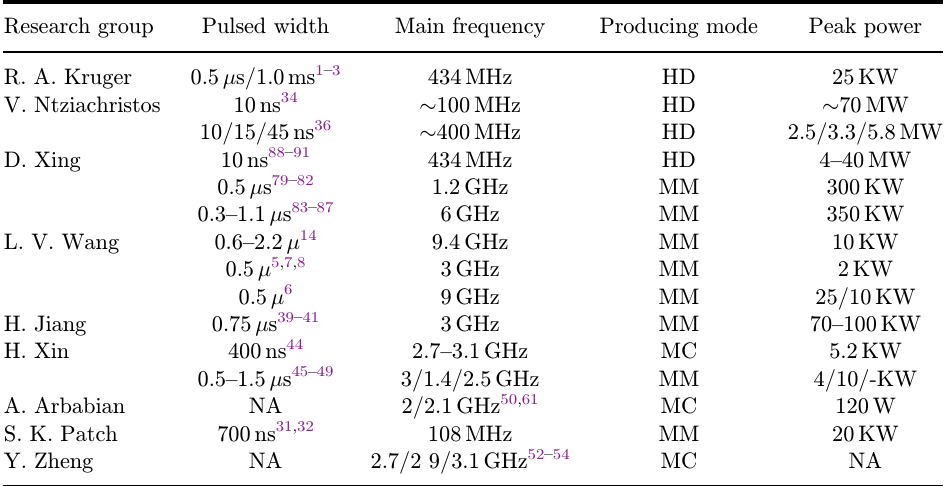
Table 1. Comparison of microwave sources by research groups.